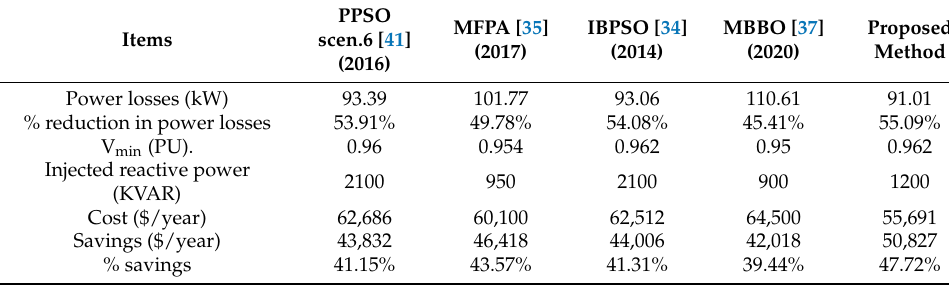
Table 6. IEEE 33 system with reconfiguration and capacitor allocation.